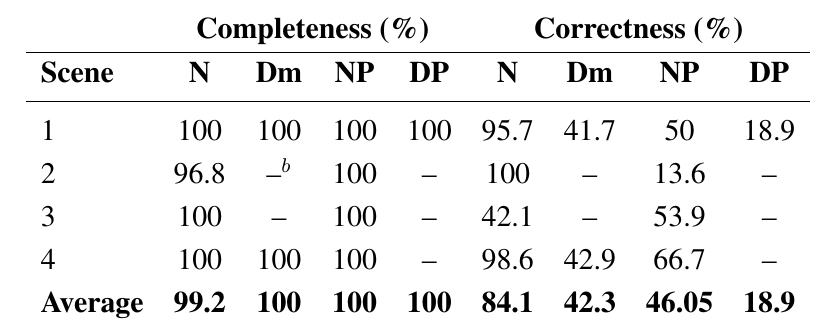
Table 7. Change detection results in terms of completeness and correctness: N = new buildings, Dm = demolished buildings, NP = new building-parts and DP = demolished